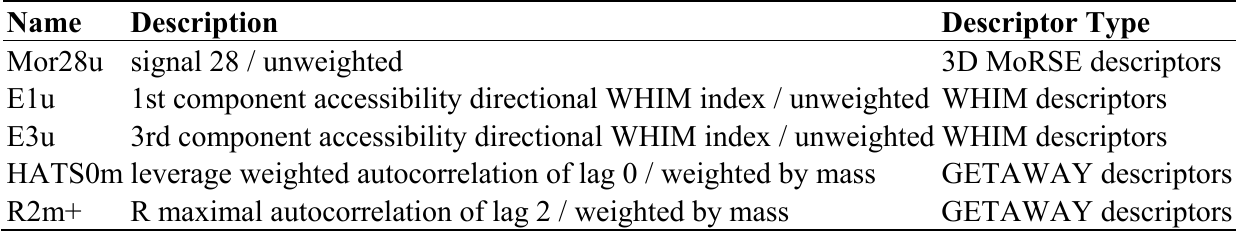
Table 1. Names and description of the descriptors in optimal